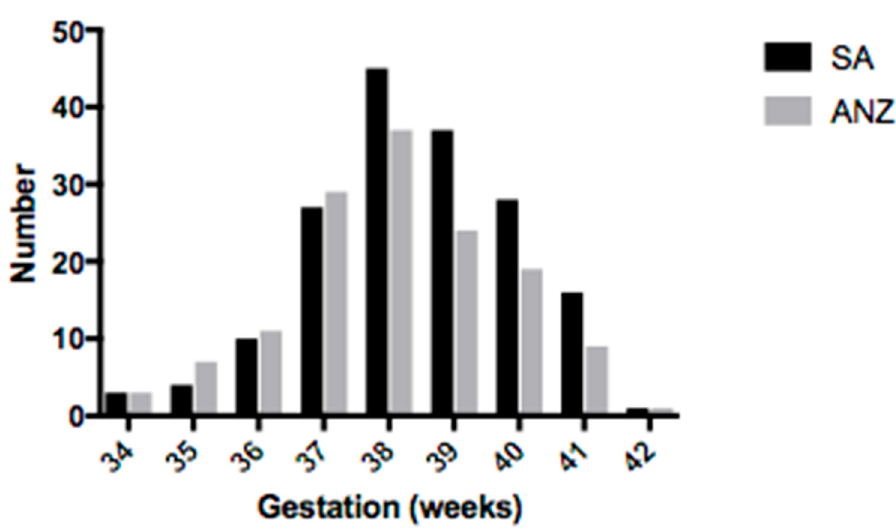
Figure 3. Distribution of small for gestational age babies according to gestational age.